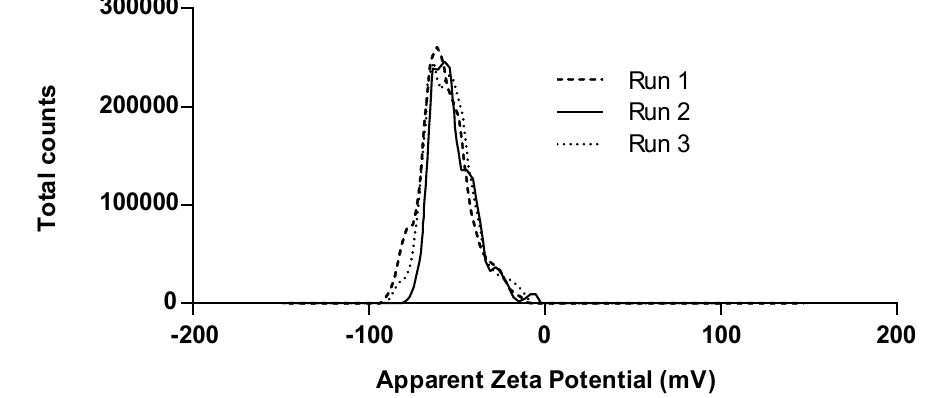
Figure 3. ζ -potential distribution of a 0.5% w / v solution at pH 10 for a representative L-NPs